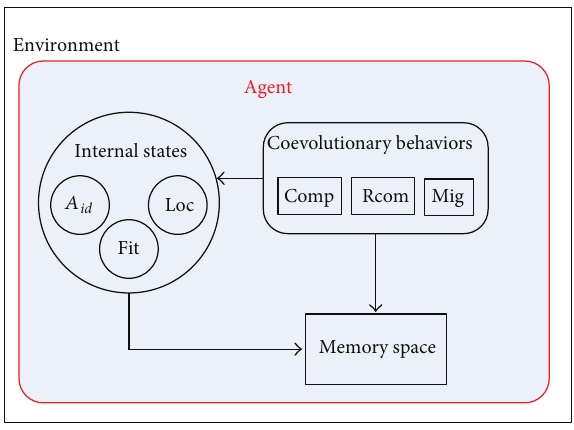
Figure 1: Memory-based agent